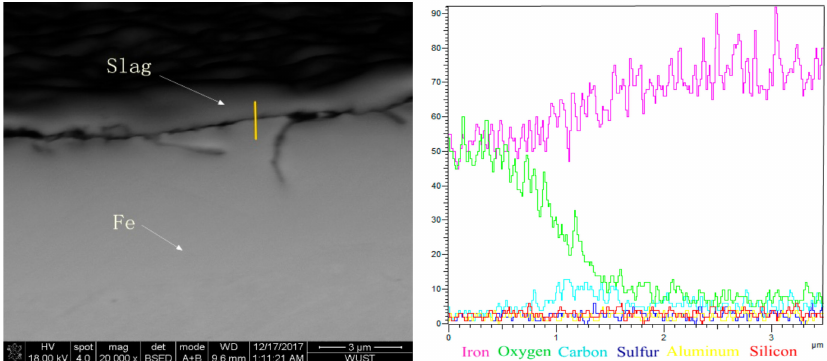
Figure 7. SEM image and EDS analyses of the reacted iron sample.